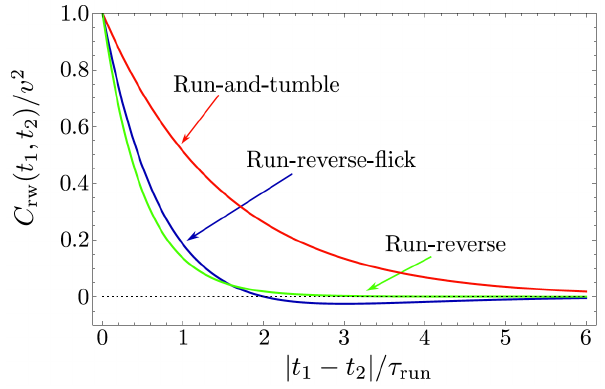
Figure 3. Velocity correlation function. The normalized velocity correlation function C rw ( t 1 , t 2 ) = v 2 is plotted as a function of dimen- sionless time D t 1 { t 2 D = t run . The curves are shown for run-and-tumble of E. coli with persistence parameter a ~ 0 : 33 (red), run-reverse with a ~{ 1 (green), and run-reverse-flick with alternating a ~{ 1 and a ~ 0 (blue). The analytical expressions are given in Eqs. (12) and (21), respectively.